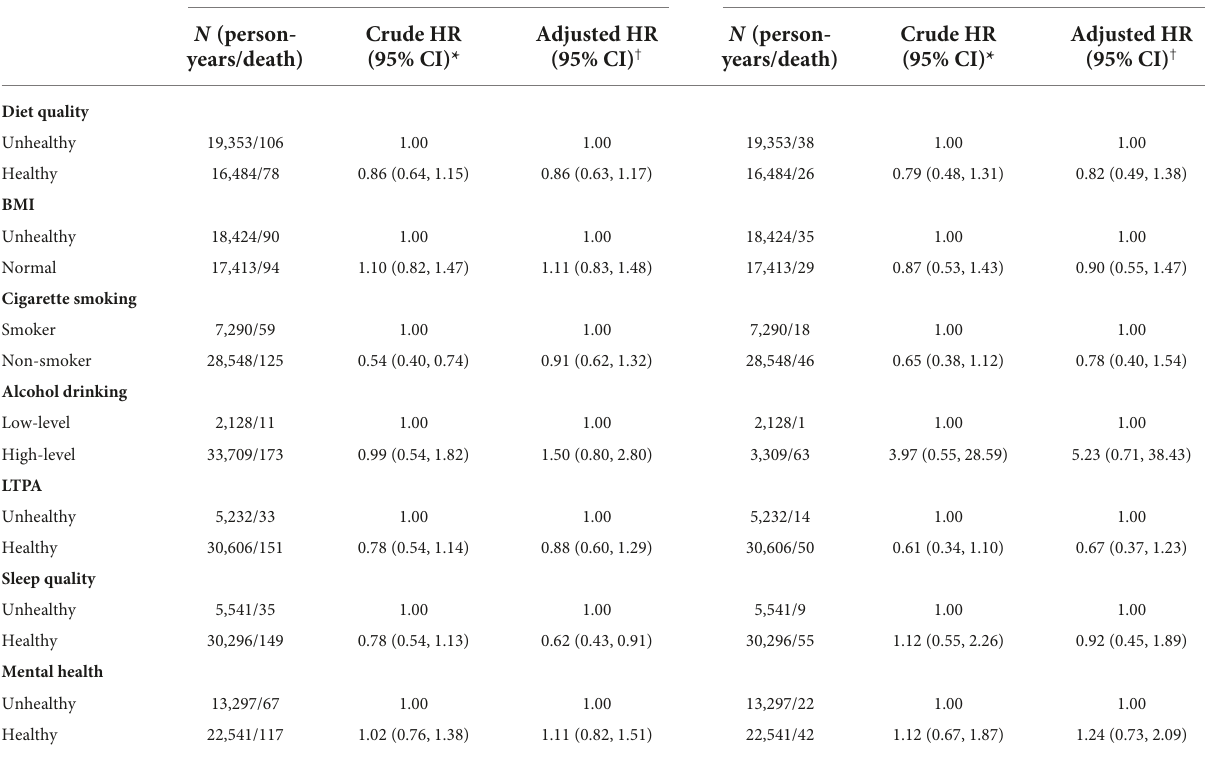
TABLE 3 Association of individual lifestyle factors with mortality. All-cause mortality Cardiovascular